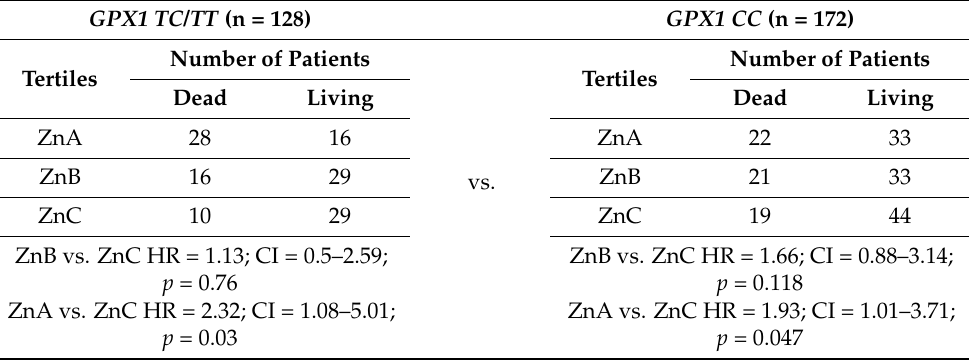
Table 5. Impact on survival of zinc serum level depending on SOD2 polymorphism (multivariable Cox regression). SOD2 TC/TT (n = 219) SOD2 CC (n = 81) Number of Patients Tertiles